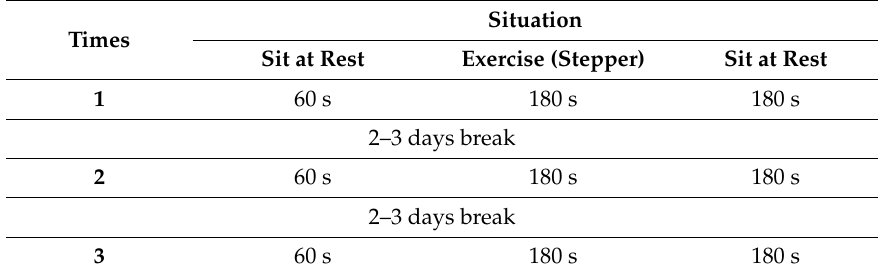
Table 3. Electrocardiogram measurement